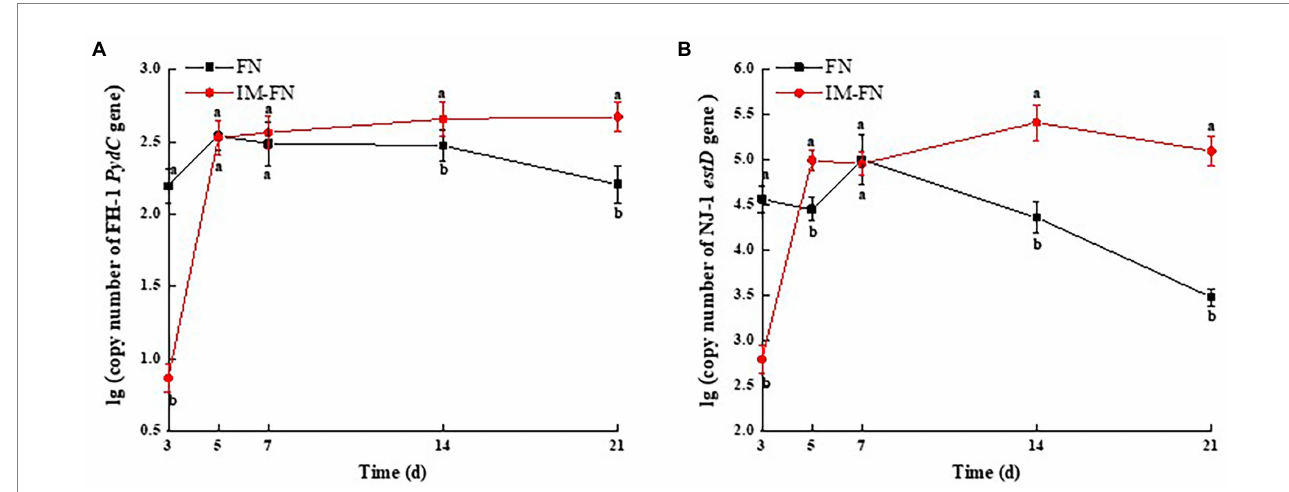
FIGURE 7 Dynamics of the colonization of strains Klebsiella variicola FH-1 and Arthrobacter sp. NJ-1 in bacterial suspensions (FN) and immobilized bacterial mixture (IM-FN) in soil for 3, 5, 7, 14, and 21 days. (A) The copy number of the PydC gene of strain FH-1 in the soils of bacterial suspensions (FN) and immobilized bacterial mixture (IM-FN) at different times. (B) The copy number of estD gene of strain NJ-1 in the soils of bacterial suspensions (FN) and immobilized bacterial mixture (IM-FN) at different time. Letters a and b indicate significant difference between the same treatment at different times based on Duncan’s significant differences test ( p ≤